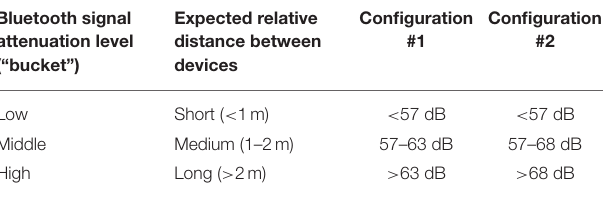
TABLE 1 | Overview of the configurations * used in the scenario-based testing. Bluetooth signal attenuation